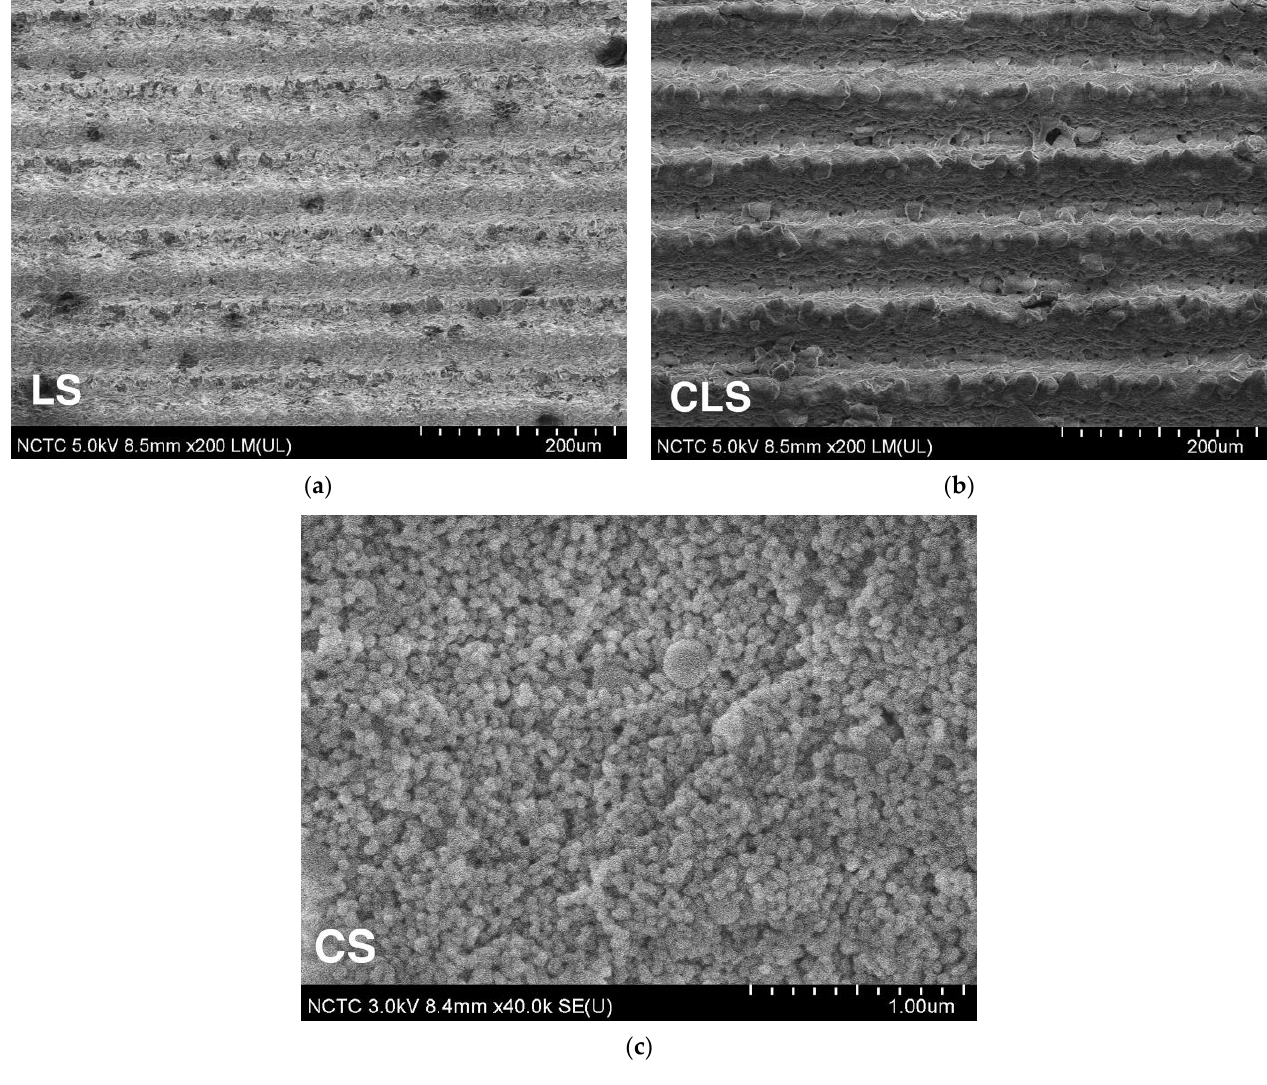
Figure 3. 3D microscopic image of the brass substrate with nanolaser treatment.